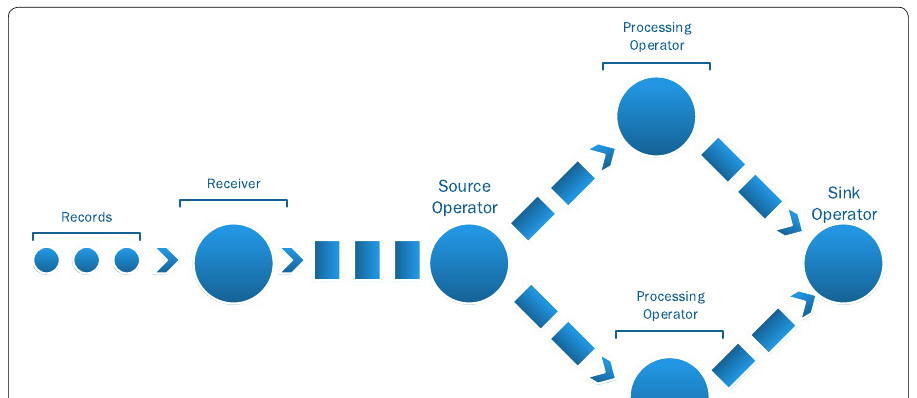
Fig. 2 Native stream processing model